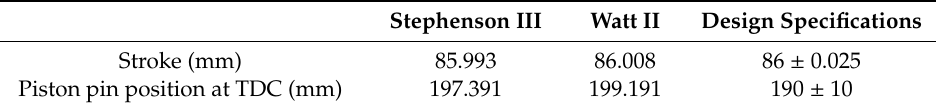
Table 4. Analysis results of the initially designed